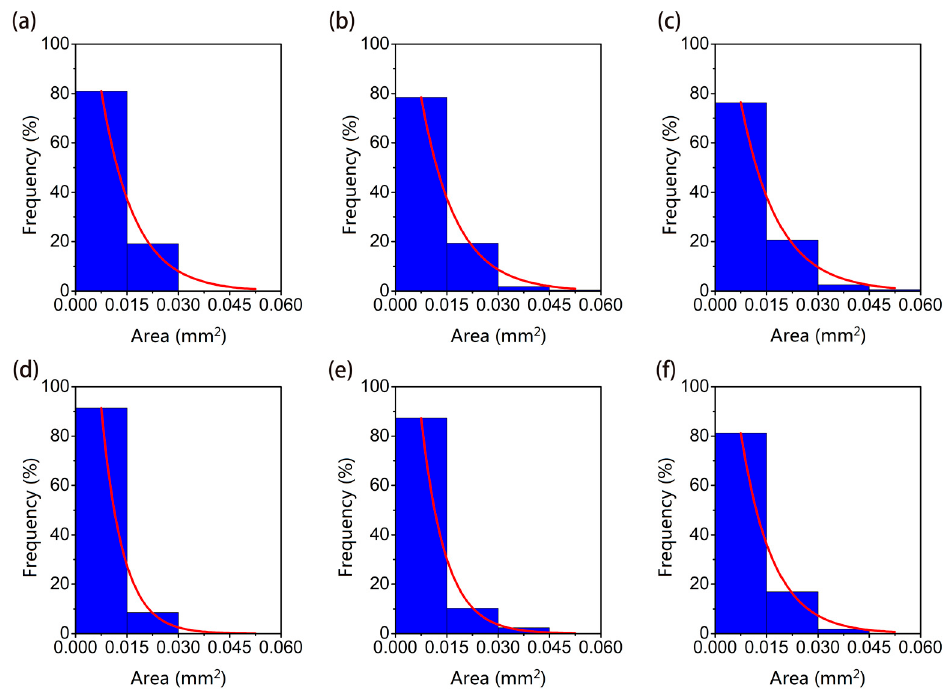
Figure 8. Probability distribution histogram of sizes of pits; ( a ) specimen L1, 30-day, ( b ) specimen L1, 60-day, ( c ) specimen L1, 90-day, ( d ) specimen L2, 30-day, ( e ) specimen L2, 60-day, ( f ) specimen L2, 90-day.